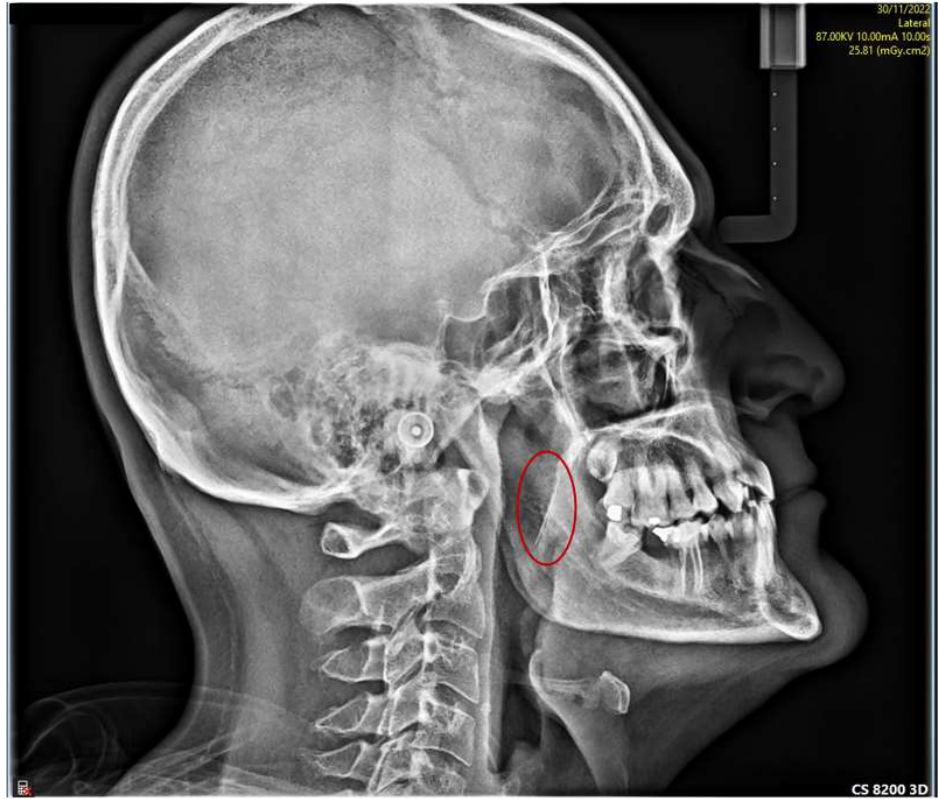
Figure 2. Latero-lateral skull teleradiography showing the fractured needle (red circle).